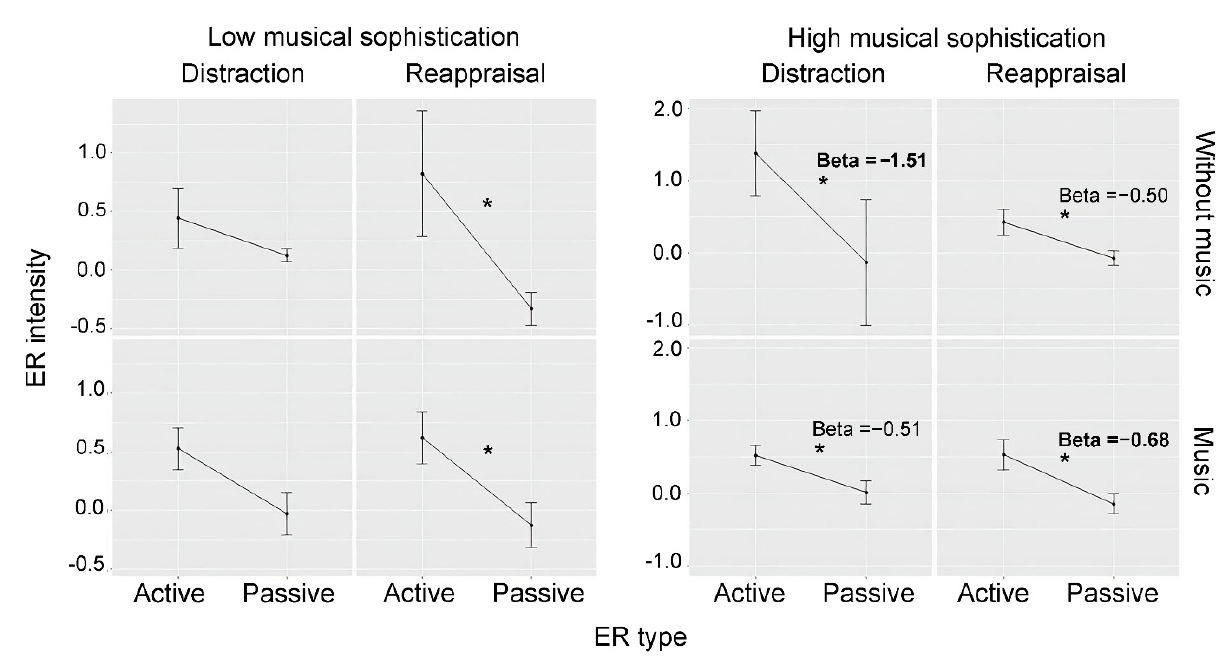
Figure 2. ER intensity according to ER type, music, and strategy (distraction vs. reappraisal) for Low vs. High-musical-sophistication participants. Asterisks indicate significant ER efficacy. Bold beta values point to increased effects of music. In low-musical-sophistication participants, music had no effects; in high-musical-sophistication participants, music benefitted reappraisal, but harmed distraction.